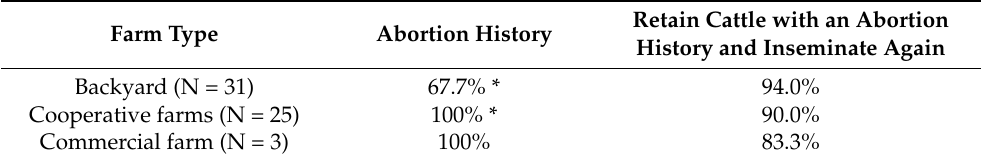
Table 2. Abortion (last 12 months) and handling in different farms in two counties in Mangshi county, Yunnan province,